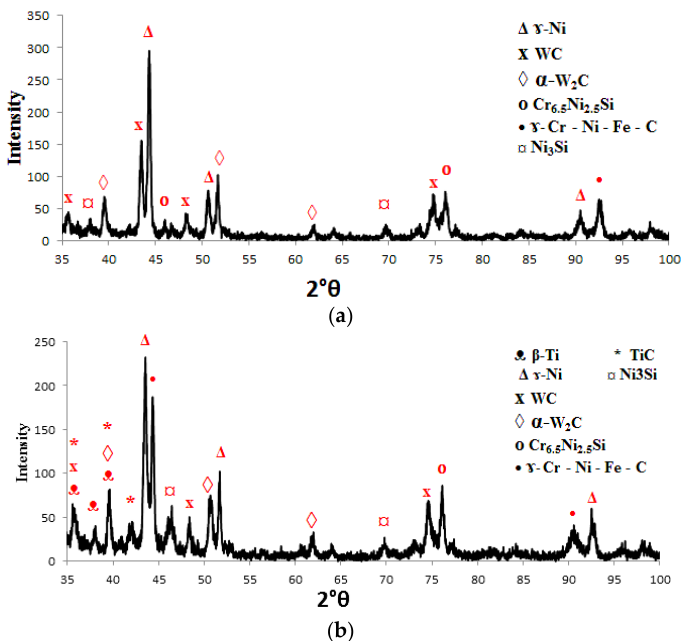
Figure 11. X-ray diffraction spectrum of the clad layer with 40NiCrBSi + 60WC blended powder at specific heat input: ( a ) 18 J·mm − 2 ; and ( b ) 59.5 J·mm − 2 (Ti-6Al-4V as the Substrate).